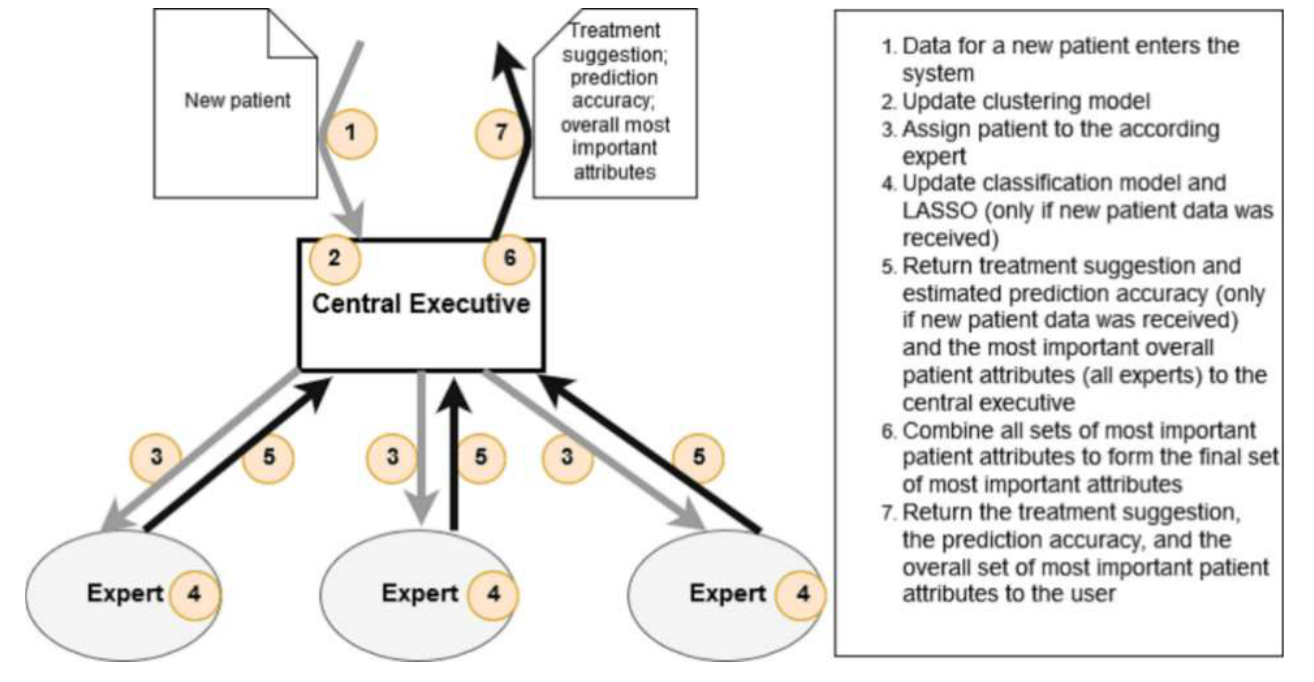
Figure 6. Division-of-Labor framework.